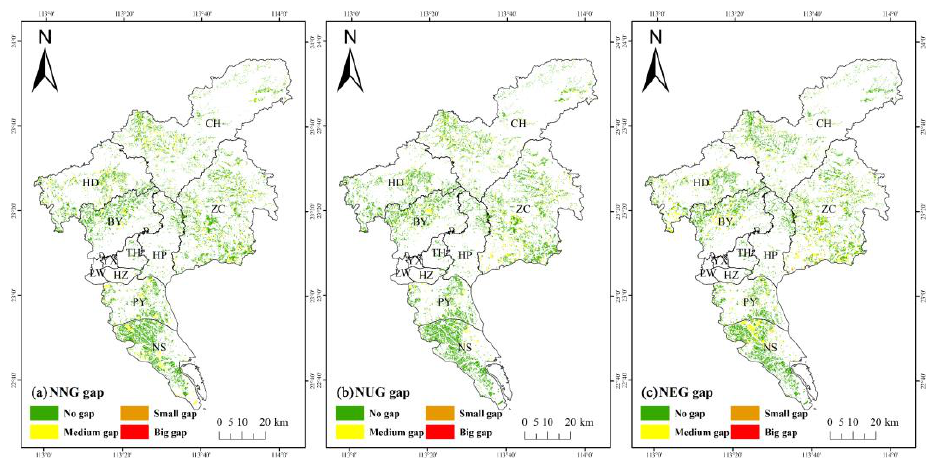
Figure 7. Comparison of the measured and estimated areas of cultivated land quality.